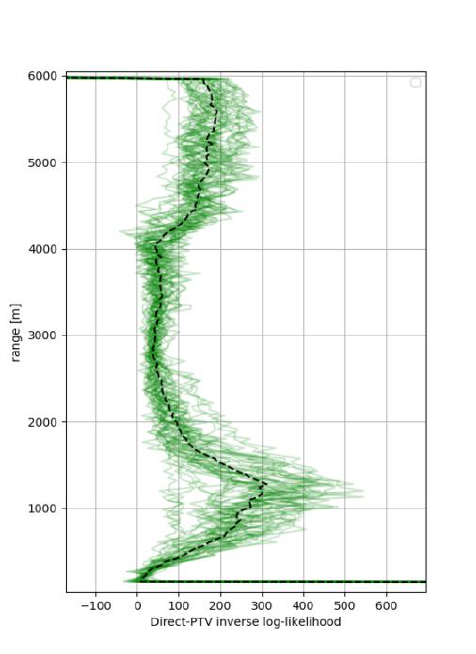
Figure 2: Difference in inverse log-likelihood between direct water vapor inversion and PTV inversion for the vertical profiles in Figure 1. The median is indicated by the dashed black line. Positive values indicate better validation in the PTV